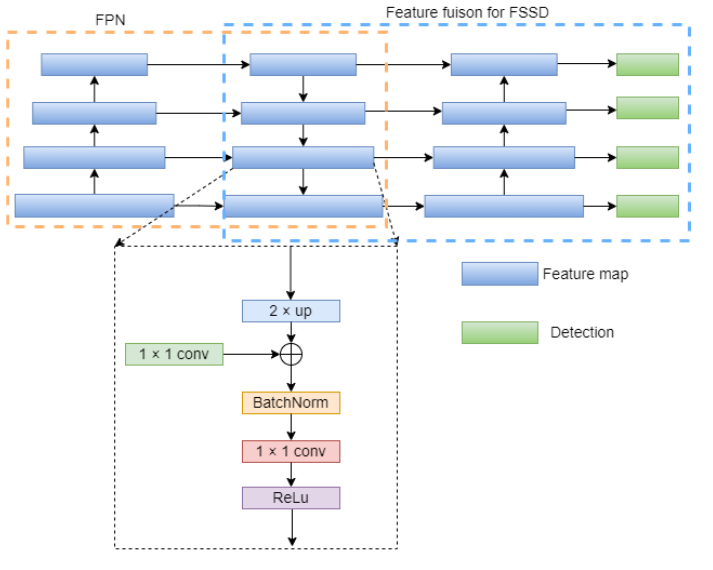
Figure 7. Multi-level feature pyramid network in FFSSD.